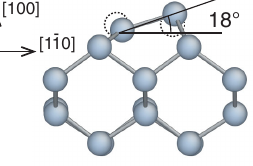
FIG. 12. Geometry of the 2 × 1 reconstruction of the (100) surface, showing the tilting of the surface dimers. The dashed circles show the surface dimer in the untilted (but rebonded)